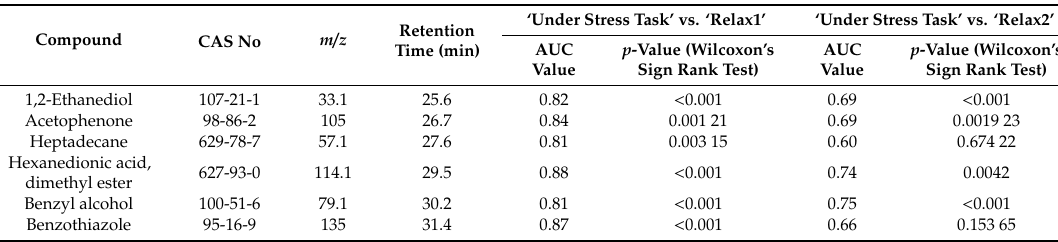
Table 1. Released amount of volatile organic component (VOC) stress biomarkers. Reproduced from Tsukuda et al. [19]. AUC, area under the